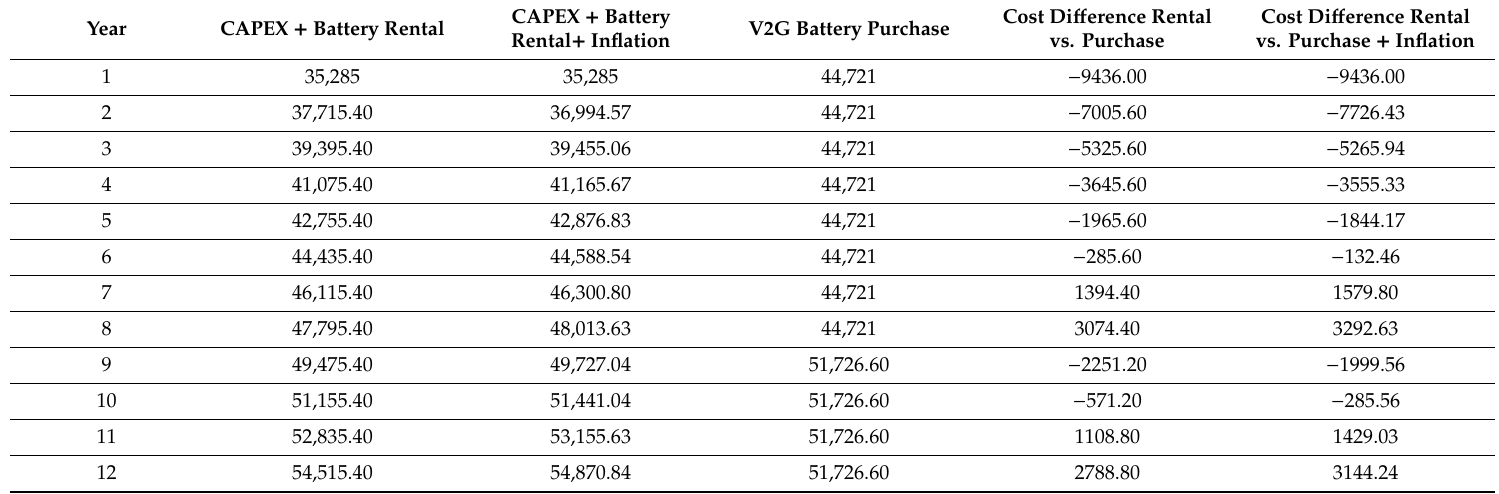
Table A4. Cumulative costs for battery rental and battery purchase for the V2G solution (figures are in